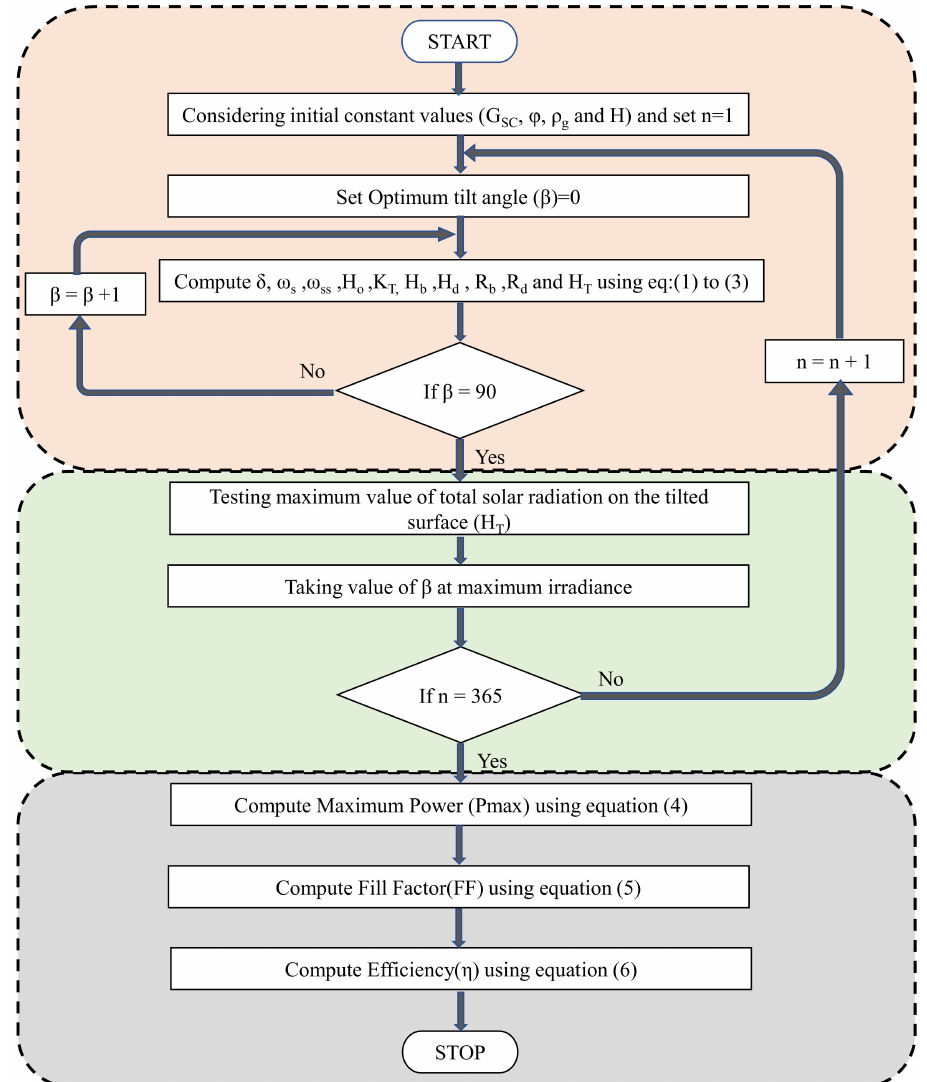
Figure 4. Flowchart of this